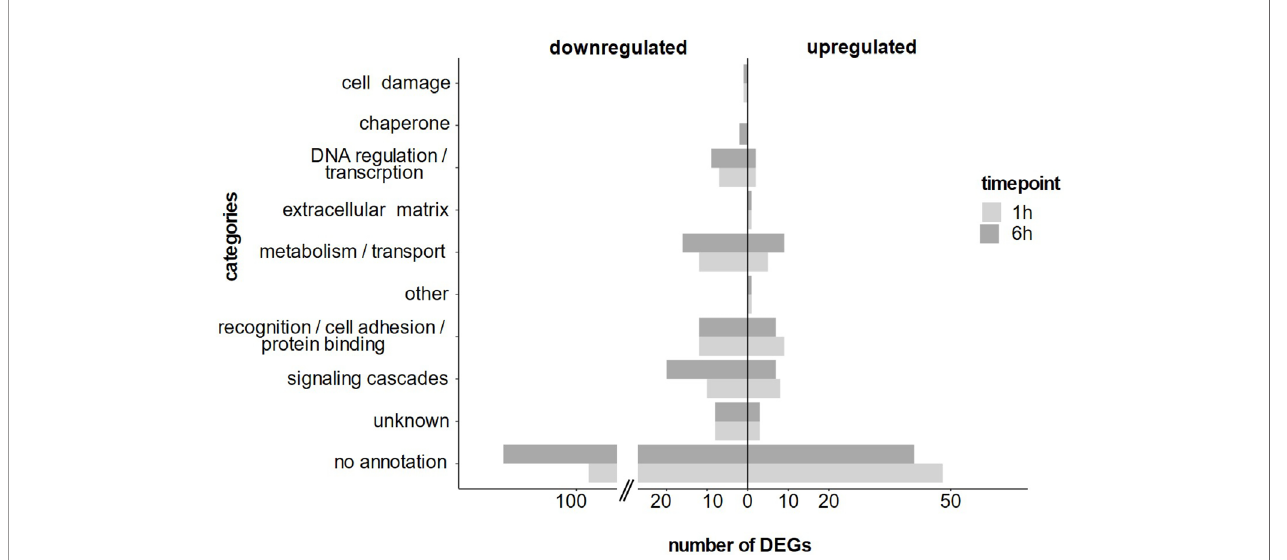
FIGURE 5 | Annotated differentially expressed genes at 1 h and 6 h after LPS exposure separated into functional categories based on their